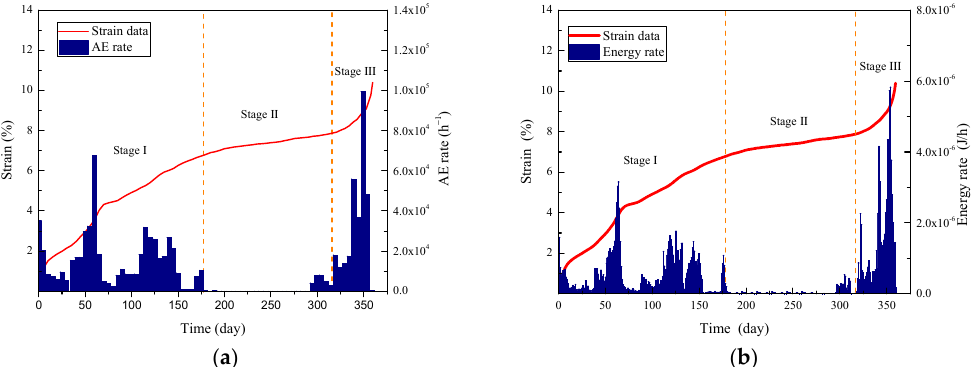
Figure 4. The curves for the AE count rate and released energy: ( a ) AE count rate vs. strain-time curve; ( b ) Released energy rate vs. strain-time